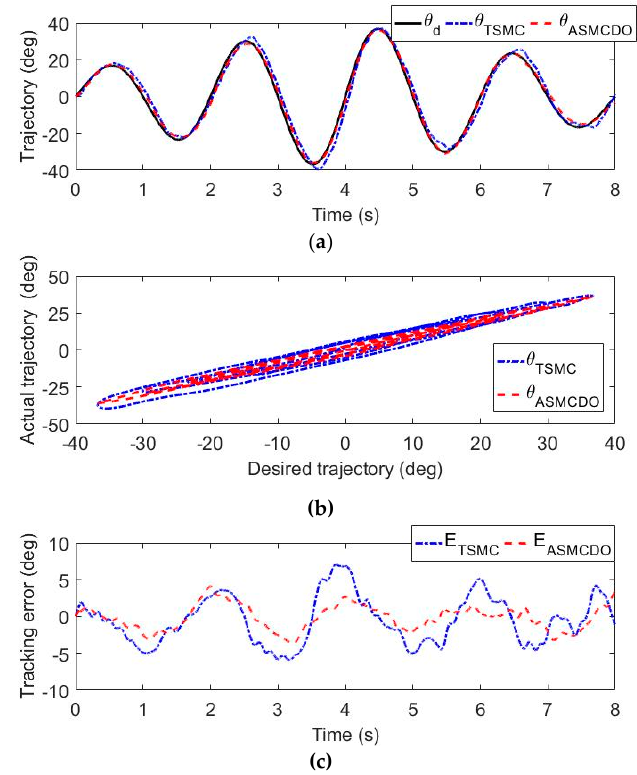
Figure 8. The comparison results of the trajectory tracking experiments for elbow flexion/extension. ( a ) Time histories of desired displacement and actual displacement. ( b ) Comparison between desired displacement and actual displacement. ( c ) The tracking error of different controllers.